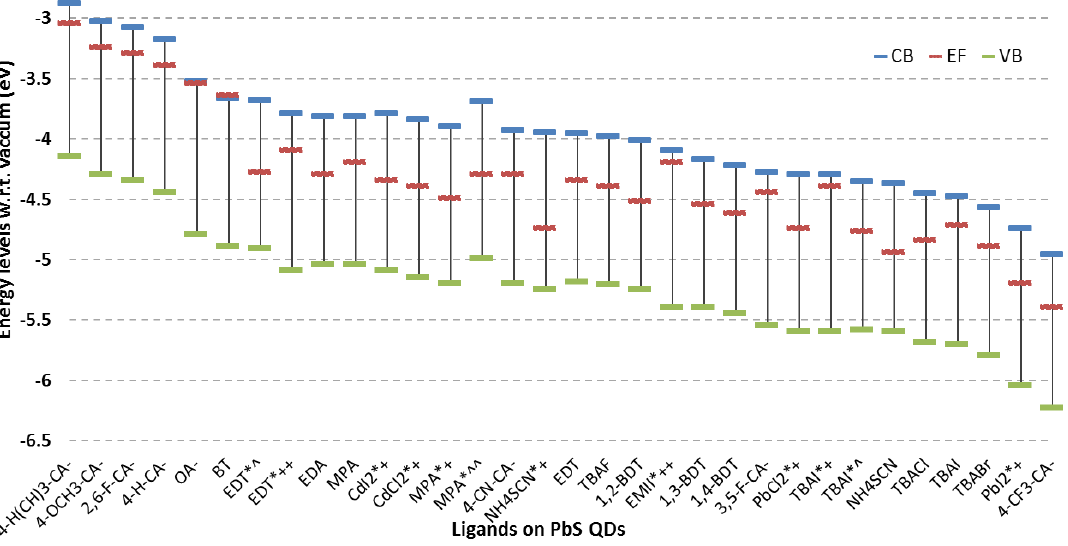
Figure 5. A compilation of the effect of 29 different QD surface passivating ligand species on the energy levels of PbS QDs with a bandgap of ≈ 1.3 eV from literature [144,145,174,176–178]. It is observed that more electronegative species push the energy levels deeper due to their higher affinity to hold electrons inside the QD by establishing a strong electric field around the QD. Samples prepared under ambient conditions are represented by the superscript “*” while other superscripts like “+” [144], “ˆ” [174], “++” [178], “ˆˆ” [176] differentiate the energy level values obtained in different literature cited for similar ligand treatments. The red, black and green lines represent the CB minimum, Fermi level and the VB minimum respectively. Details are available in the Supplementary Materials.